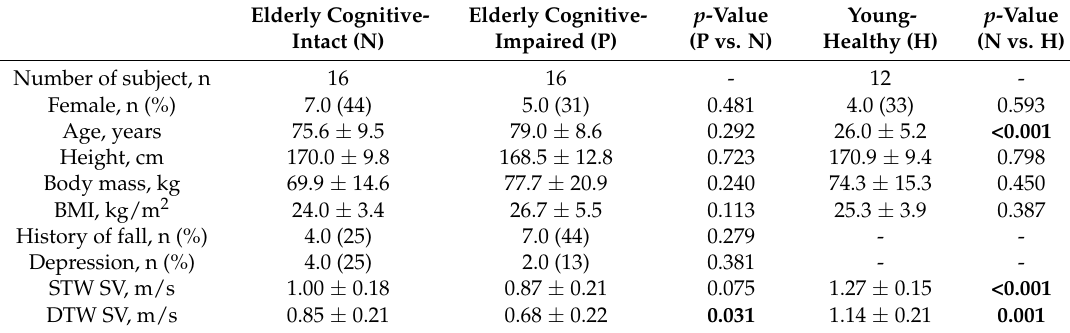
Table 1. General characteristics of the study population.